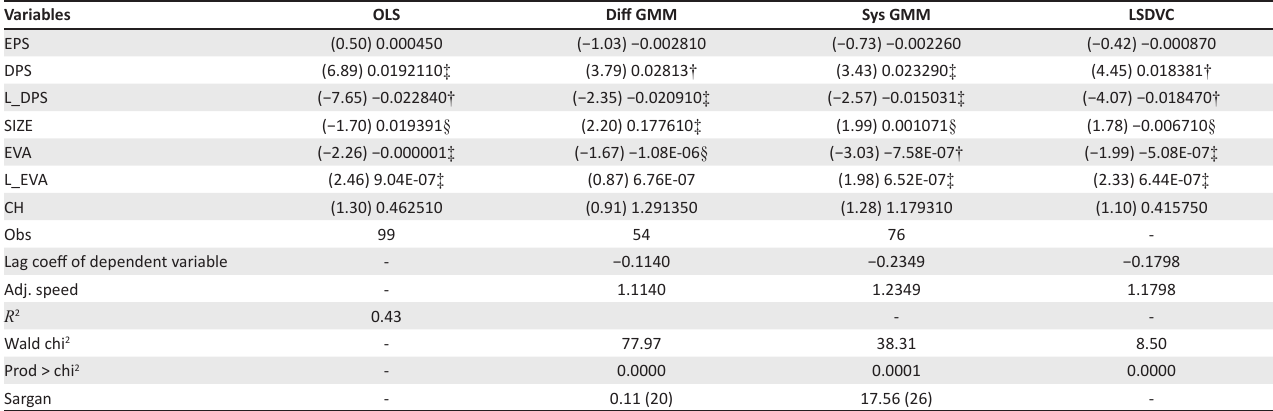
TABLE 7: Regression results for the dividend relevance pay-out model and determinants of change in dividends–Panel 3. Variables